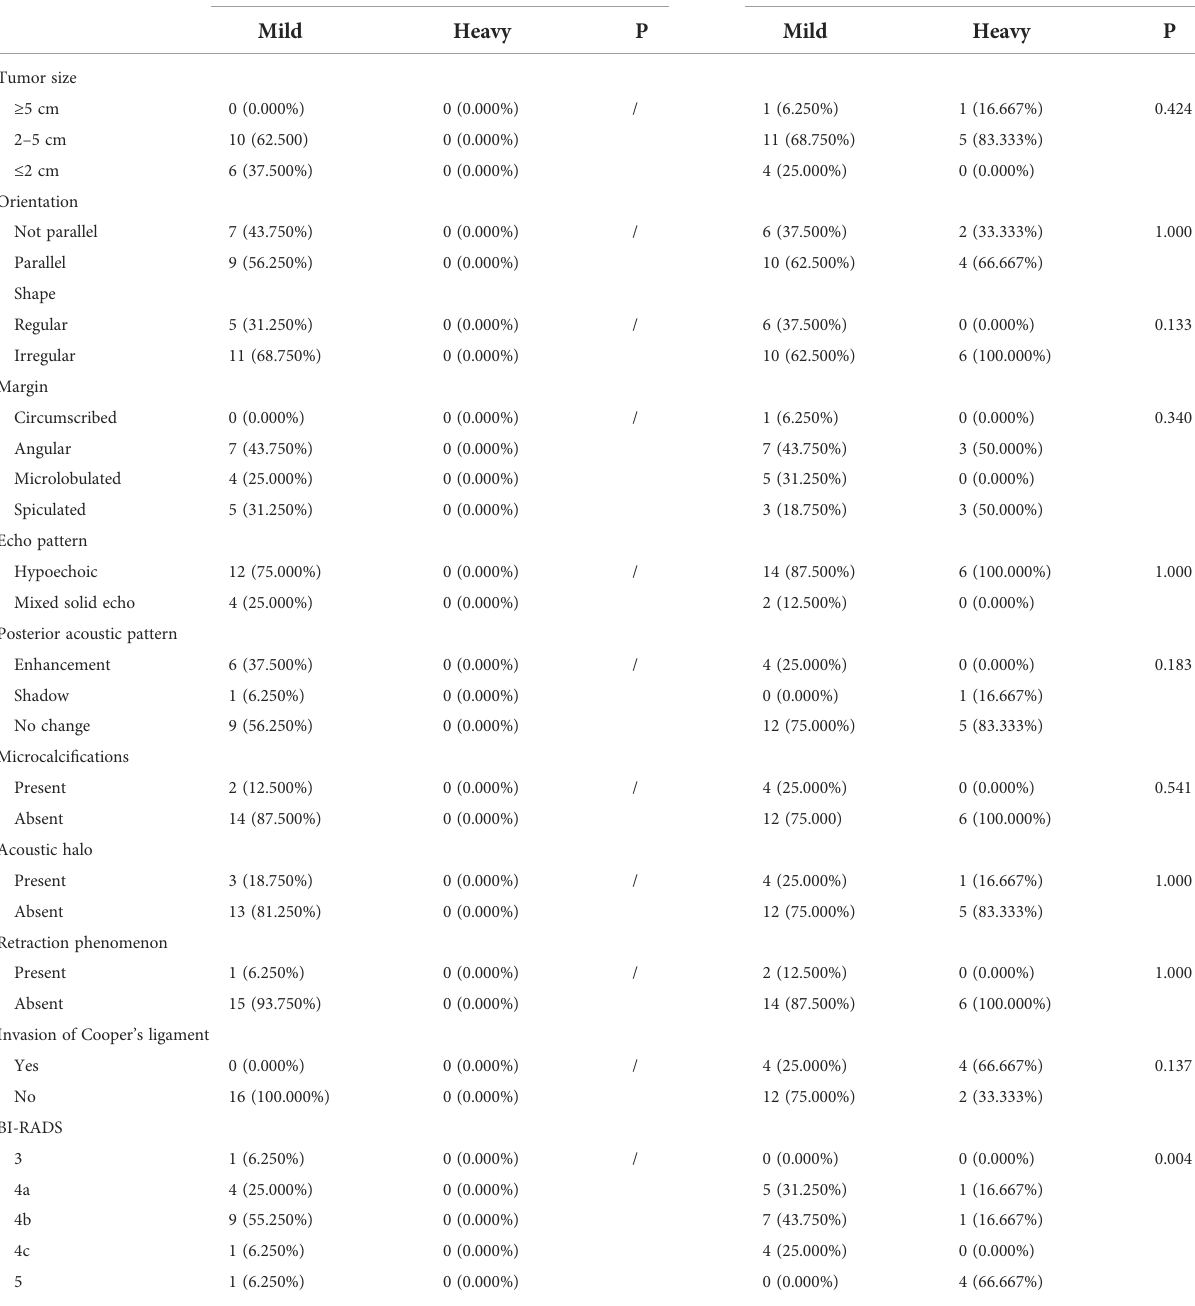
TABLE 5 Differences of lymph node tumor burden of triple-negative type breast cancer regarding different ABVS